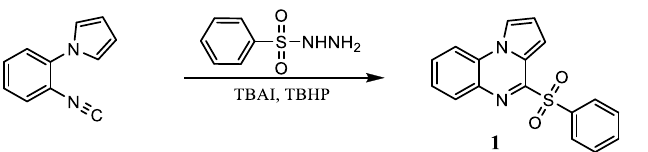
Figure 17. Radical isocyanide cyclization with benzene sulfonyl hydrazide in the presence of TBAI and TBHP.